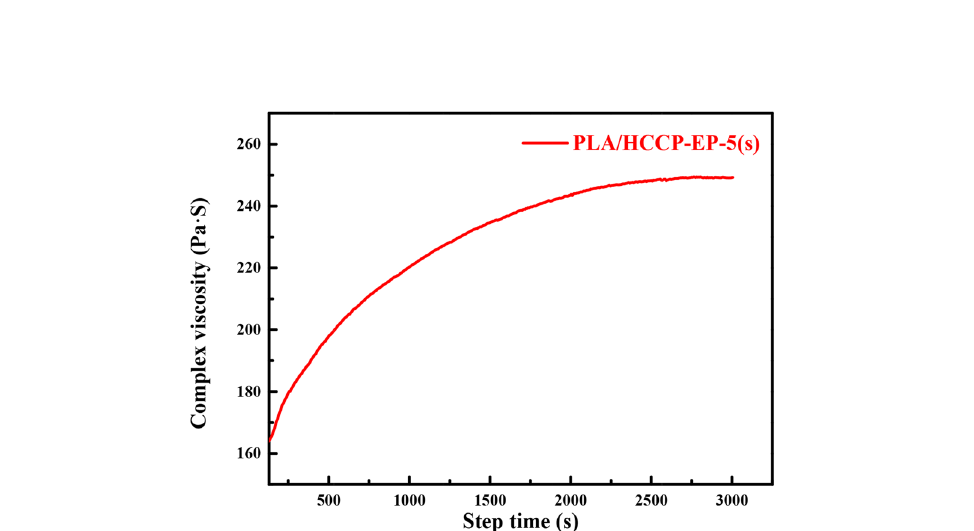
Figure A4: The TG and DTG curves of HCCP - EP.